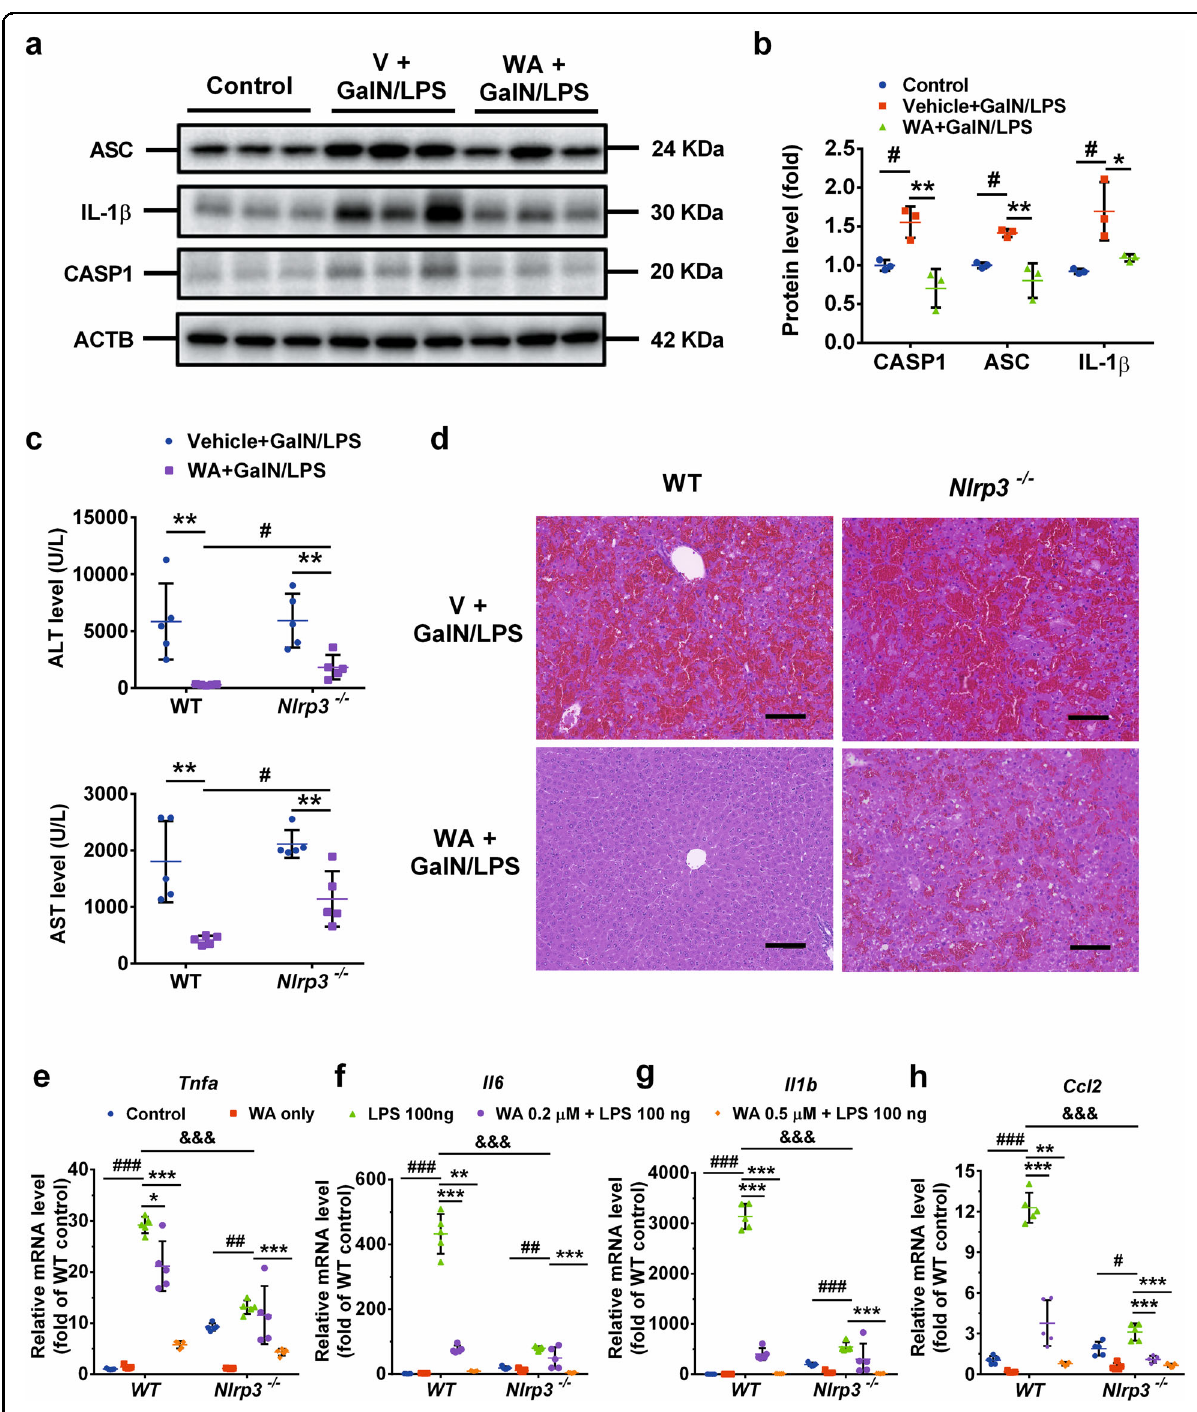
Fig. 6 WA attenuated the hepatic in fl ammasome activation in WT mice, while the hepatoprotective effect of WA was partially compromised in Nlrp3 − / − mice. a Representative images of western blot analyses for CASP1, ASC and IL-1 β in WT livers ( n = 3). b Quantitation for CASP1, ASC and IL-1 β ( n = 3). c Serum ALT and AST levels in GalN/LPS-treated WT or Nlrp3 − / − mice treated with or without WA. d Representative hepatic H&E staining of V or WA-treated WT or Nlrp3 − / − mice subjected to GalN/LPS challenge, scale bar 50 µm. Effect of WA in mRNA levels of Tnfa ( e ), Il6 ( f ), Il1b ( g ), and Ccl2 ( h ), in LPS-treated WT and Nlrp3 − / − macrophage. One-way ANOVA or two-tailed t test was used for statistical analyses. Data were presented as mean ± SD ( n = 5 unless otherwise indicated). For the animal study, # p < 0.05 versus Control; * p < 0.05 or *** p < 0.005 versus V + GalN/LPS. For the macrophage culture study, # p < 0.05, ## p < 0.01, or ### p < 0.005 versus WT Control or Nlrp3 − / − Control, respectively; * p < 0.05, ** p < 0.01, or *** p < 0.005 versus WT LPS or Nlrp3 − / − LPS, respectively. &&& p < 0.005 represents comparison between WT LPS and Nlrp3 − / − LPS